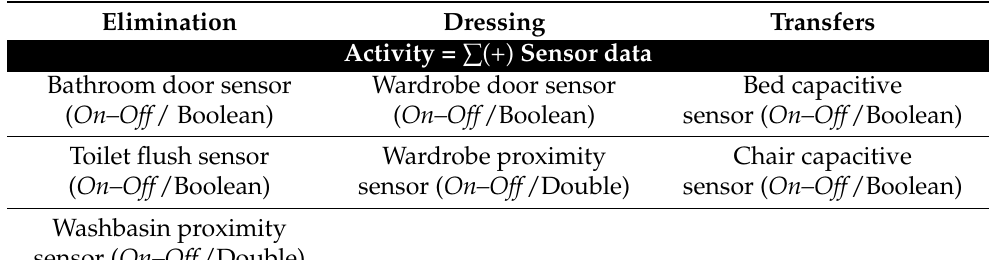
Table 10. Orchestration of